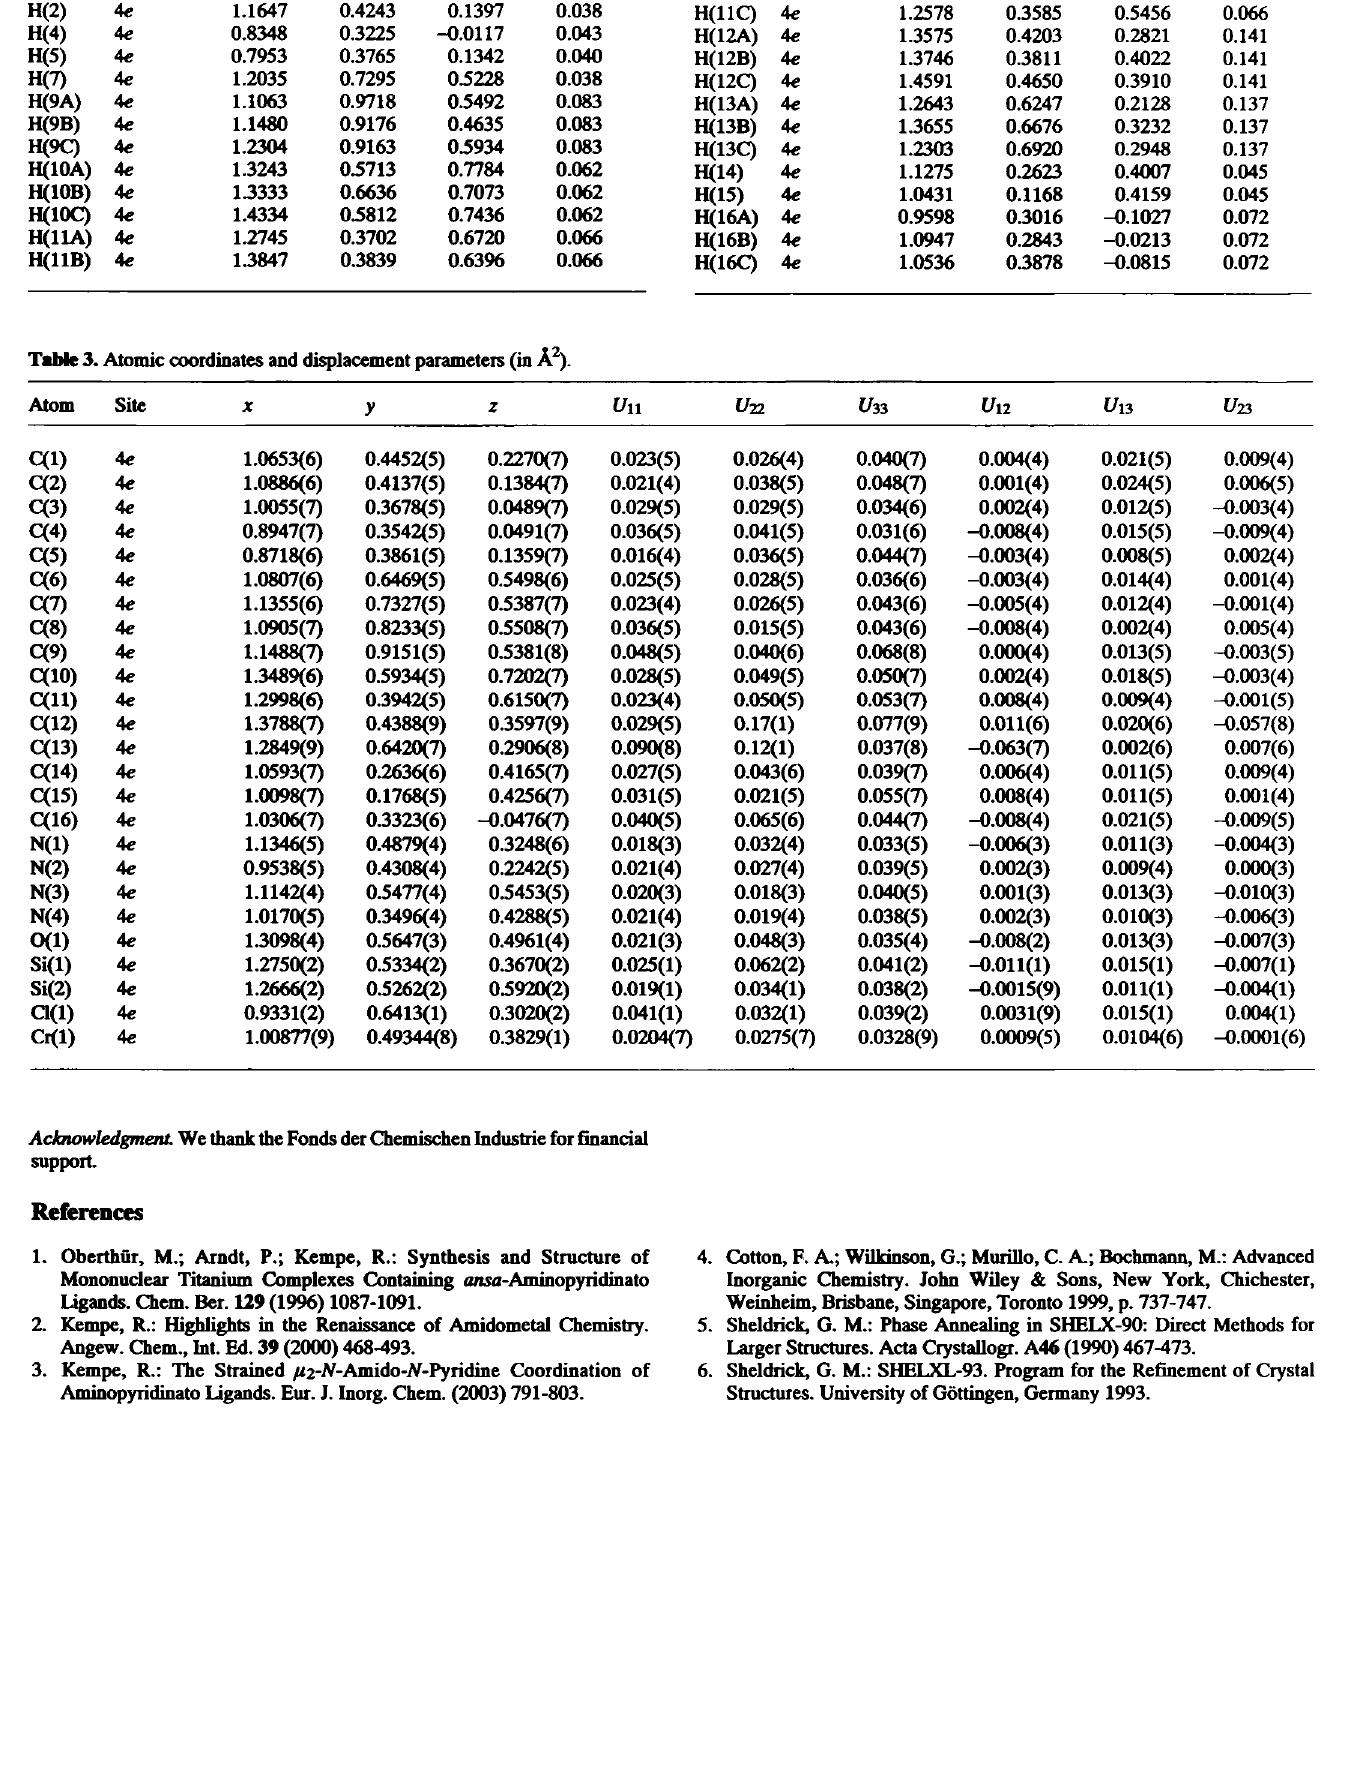
Table 3. Atomic coordinates and displacement parameters (in A 2